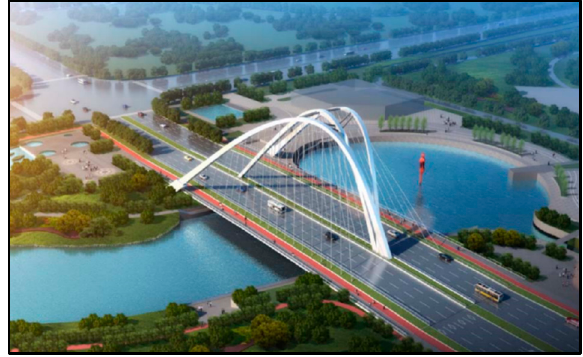
Figure 1. The rendering of golden island bridge.